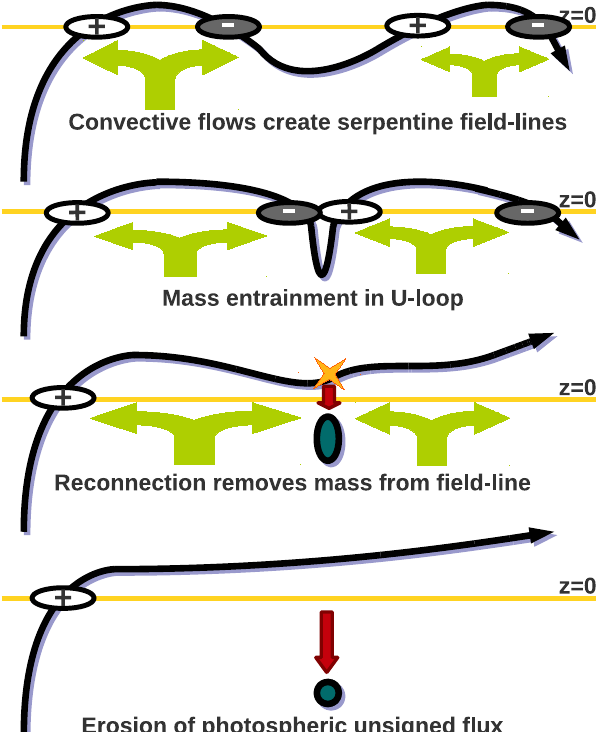
Figure 37: Schematic drawing illustrating the effect of granular flows on magnetic polarities from a serpentine field line. Image reproduced with permission from Cheung et al. (2010), copyright by